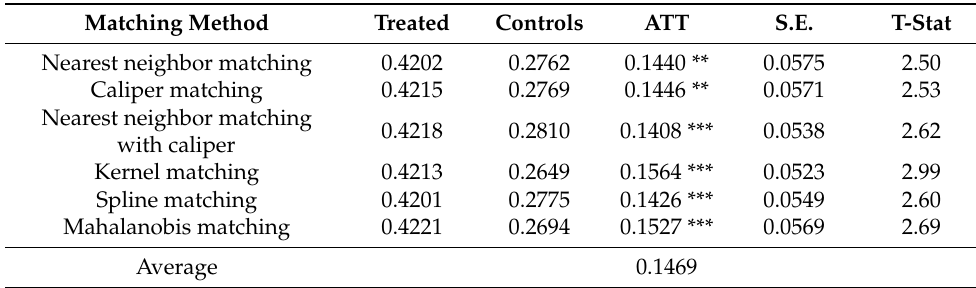
Table 5. The effect of formal credit participation on online sales utilization.